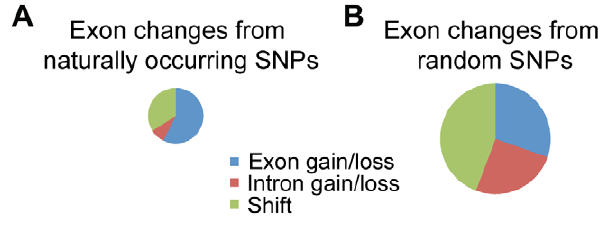
Figure 1. Naturally occurring SNPs cause fewer gene model differences than randomly placed SNPs. A) Gene model differ- ences between vdB and vdB*, where all base pair changes were made at naturally occurring SNP positions between UCB and vdB. B) Average gene model differences between vdB and 100 genomes in which SNPs were randomly relocated. Area in circle is proportional to the number of changes observed.